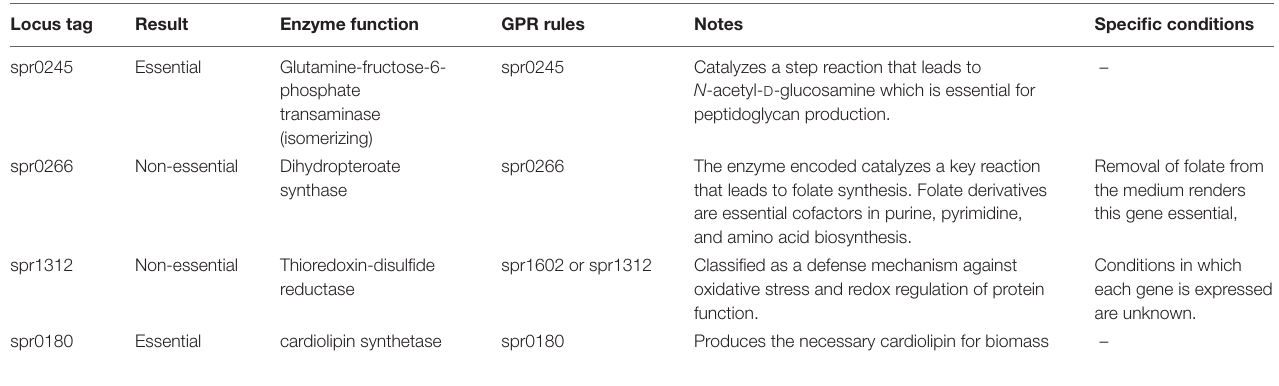
TABLE 7 | Examples of the analysis of essential genes presented in metabolic model.